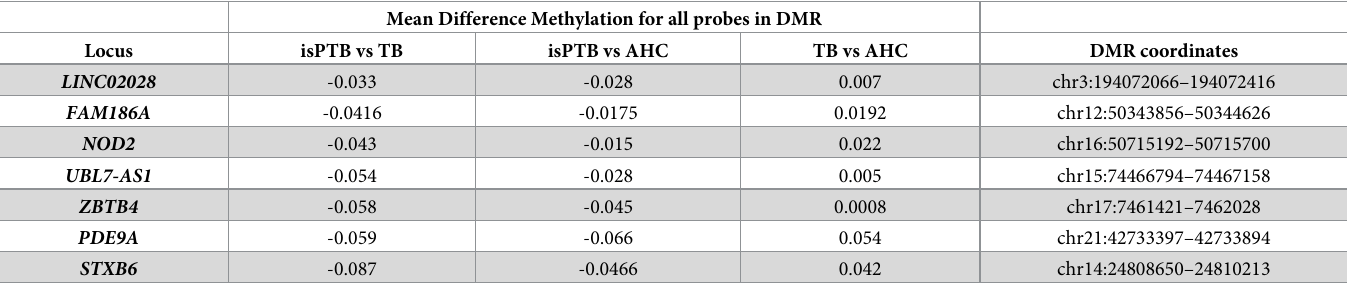
Table 3. Summary of isPTB profile